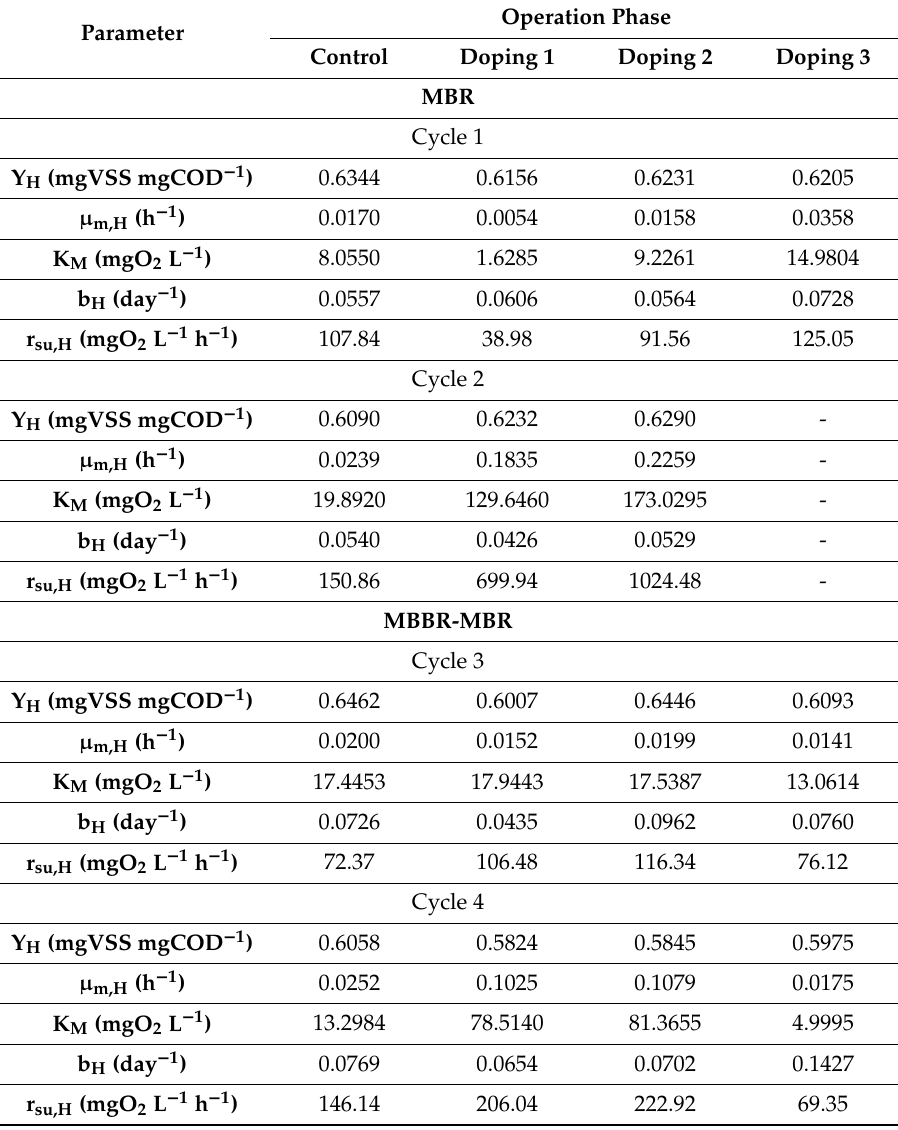
Table 5. Kinetic parameters for heterotrophic biomass in the absence (control) and presence (doping) of carbamazepine, ciprofloxacin, and ibuprofen for the four operation cycles of membrane bioreactor (MBR) and bed biofilm reactors–membrane bioreactor